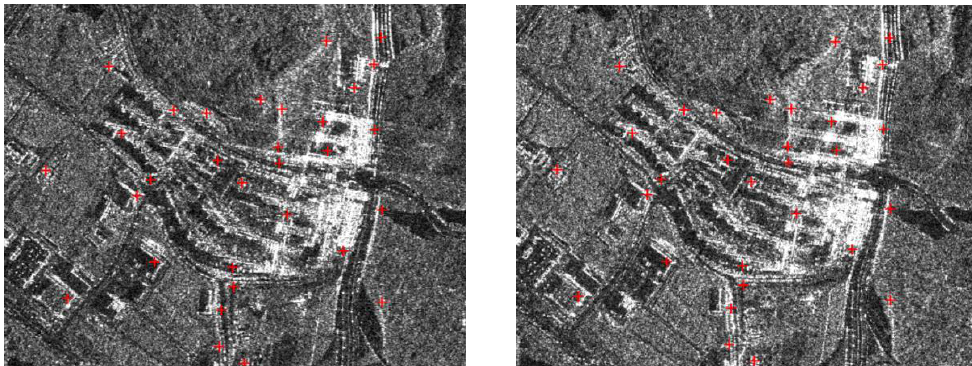
Figure4. Results of Test Image in Building